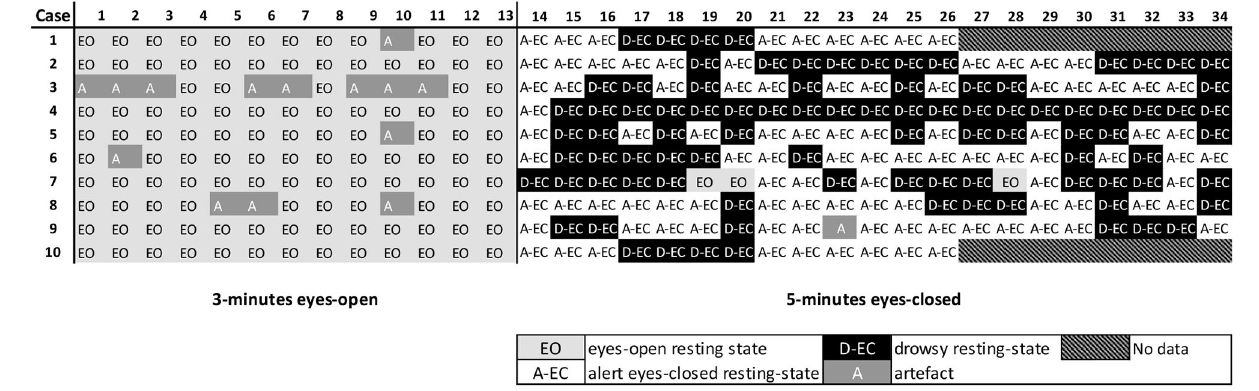
FIGURE 2 | Example of the scoring of the MEG recording for the first subjects. Represented are 34 epochs (13.1072s each) for the first 10 subjects. Subjects 1 and 10 had a shorter recording than that was defined in the protocol. Marked in white are epochs that were scored as resting-state alert eyes-closed (A-EC) epochs. Marked in black are epochs that were scored as drowsy eyes-closed (D-EC) epochs. Marked in light gray are epochs that were scored as the eyes-open (EO) epochs. Marked in a darker gray are epochs where a clear artifact was present (A). Note the presence of drowsiness in some subjects soon after the start of the eyes-closed part of the recording. Also note the opening of the eyes during the “eyes-closed” (EO)